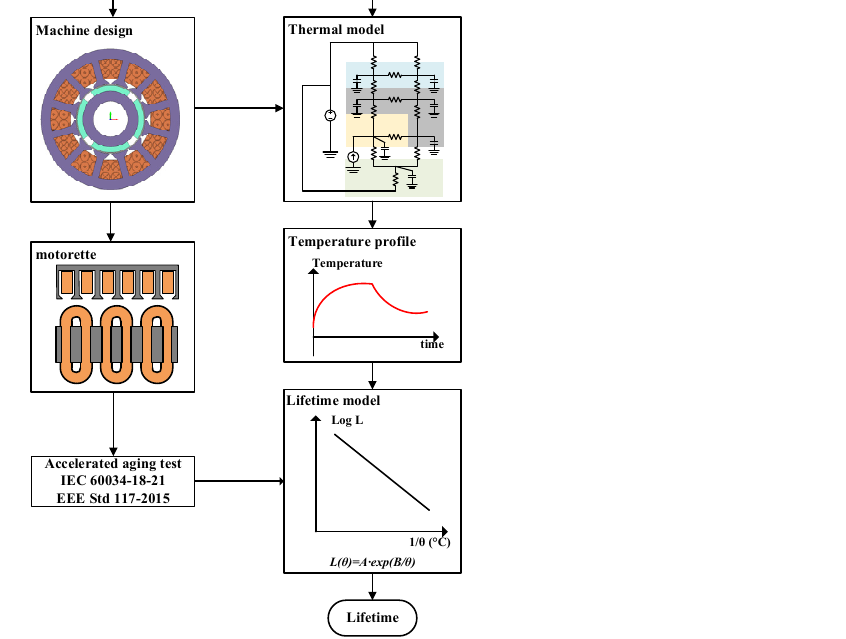
Figure 8. Lifetime prediction of low-voltage inverter-fed EMs using the POF approach.